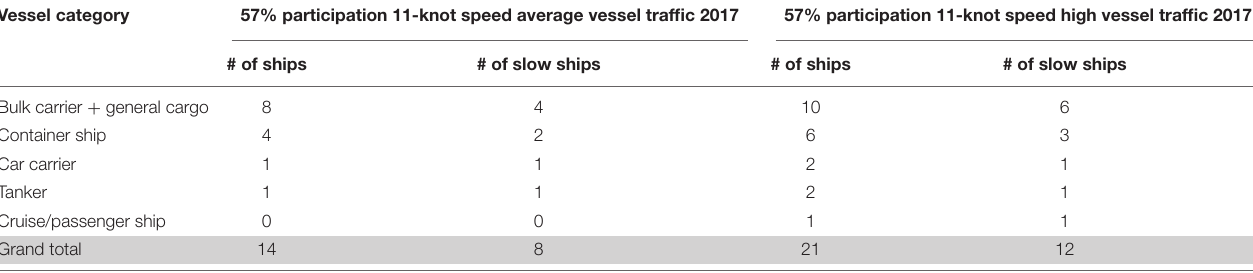
TABLE 3 | A comparison of average observed number of piloted commercial vessels per day during the 61 days slowdown period, and the assumed transit numbers for average and high traffic volume scenarios. Vessel